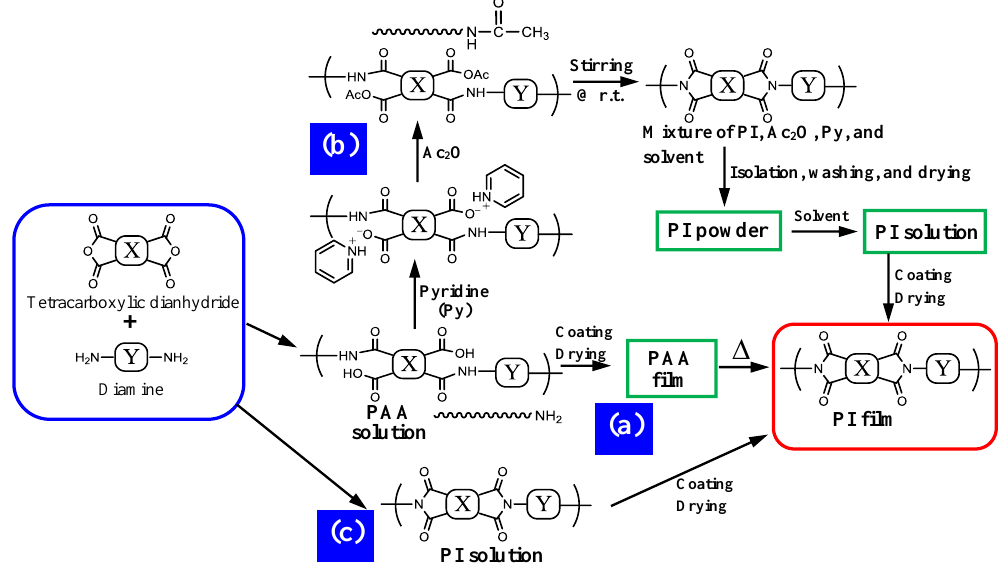
Figure 2. The schemes of PAA polymerization, imidization, and film preparation via different pathways: (a) two-step method (thermal imidization of PAA cast films), (b) chemical imidization method, and (c) one-pot method.